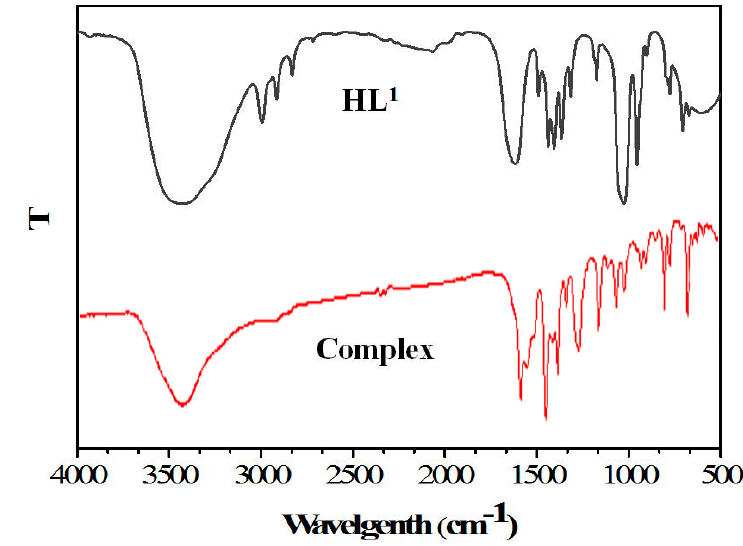
1 and the Co(II)